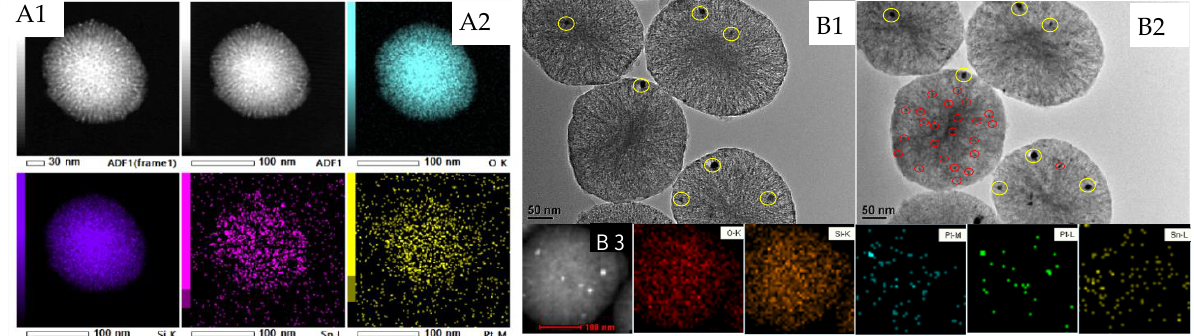
Figure 5. TEM images and EDS elemental mapping of calcined ( A1 , A2 ) Pt 1 Sn 2 /DMSN and ( B1 – B3 ) Pt 3 Sn 9 /DMSN catalyst.